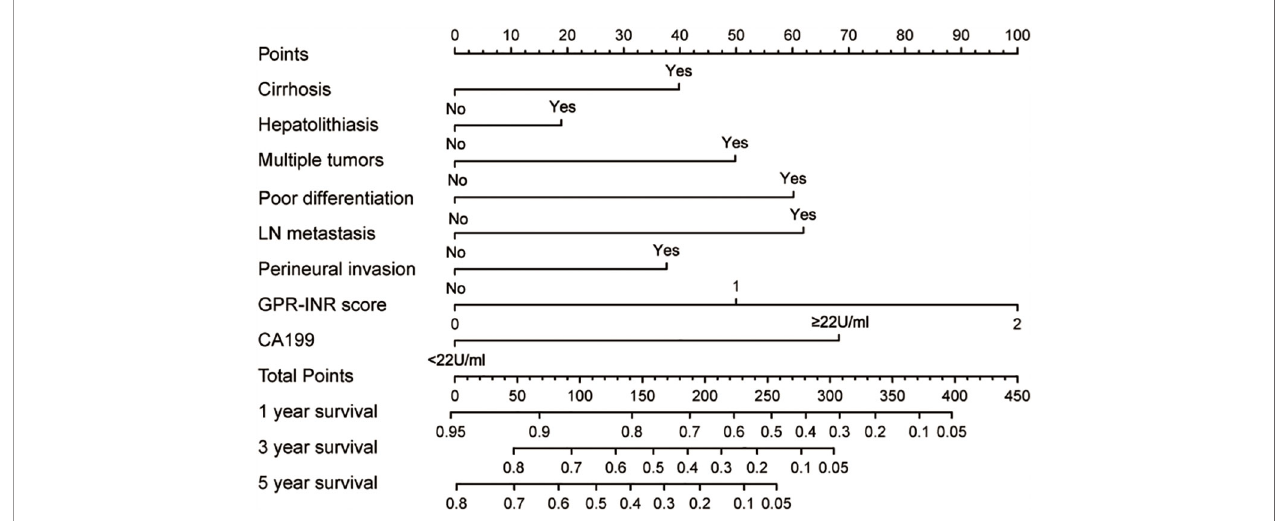
FIGURE 3 | The GPR-INR nomogram. (To use the nomogram, the patient ’ s value was located on each variable axis, and a line was drawn to determine the individual points. The sum of these points was located on the total points axis, and a line was drawn downward to determine the likelihood of 1-, 3- or 5-year OS).